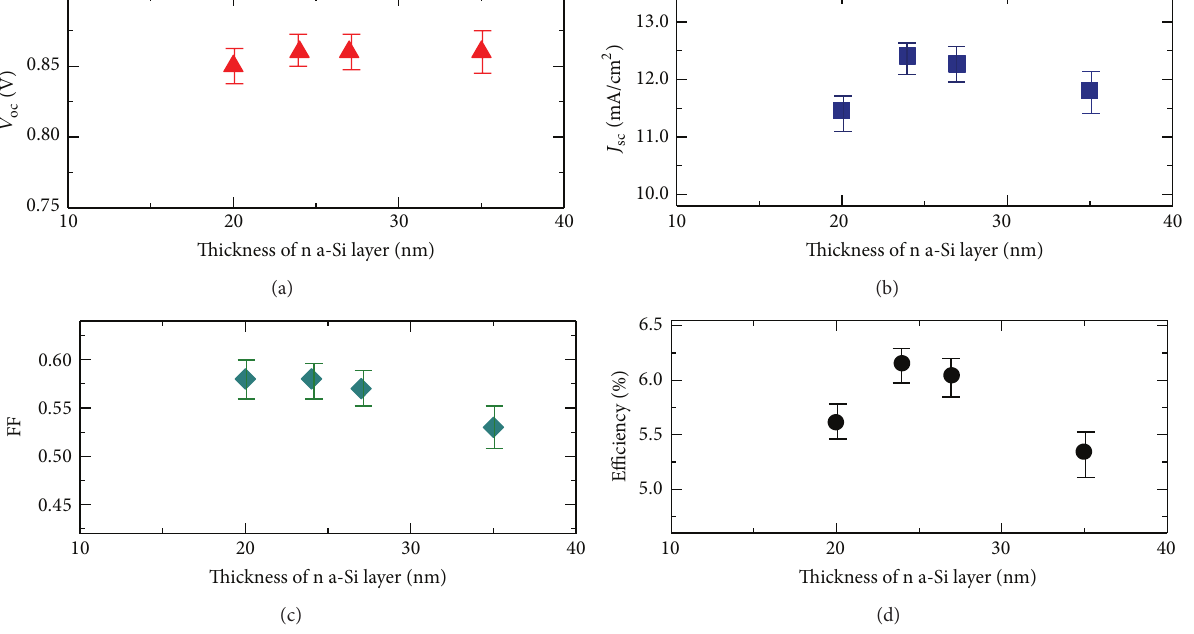
Figure 5: Photovoltaic parameters of flexible n-i-p amorphous silicon solar cells as a function of thickness of the n a-Si:H